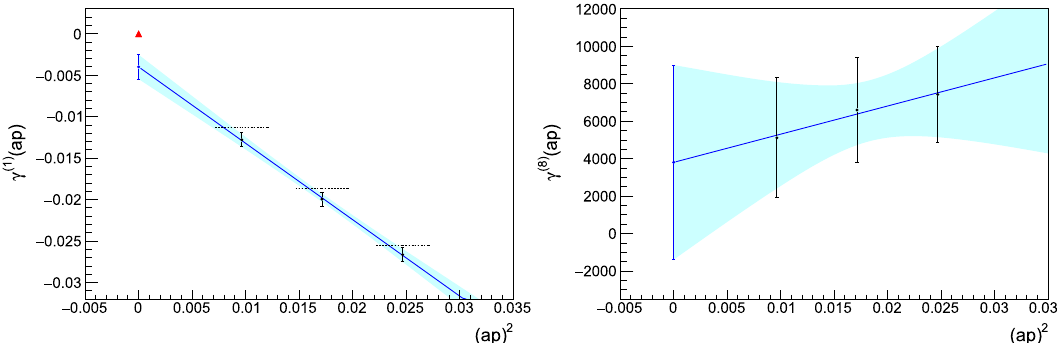
Fig. 4 Determination of the coefficient m ( 8 ) c . The errors overshadow the value of the critical mass, which is compatible with zero. Notation as in Fig. 1 the impact of the uncertainty of m